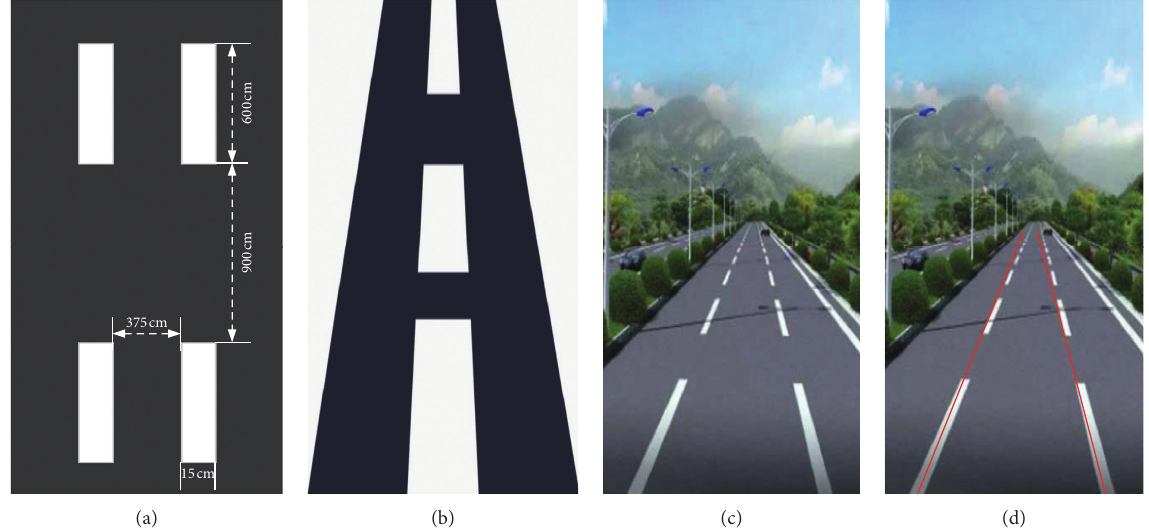
Figure 8: The standard map example (a) and schematic diagram (b) of the Chinese expressway lane lines, the real picture (c), and the labeling result map of the lane lines (d).